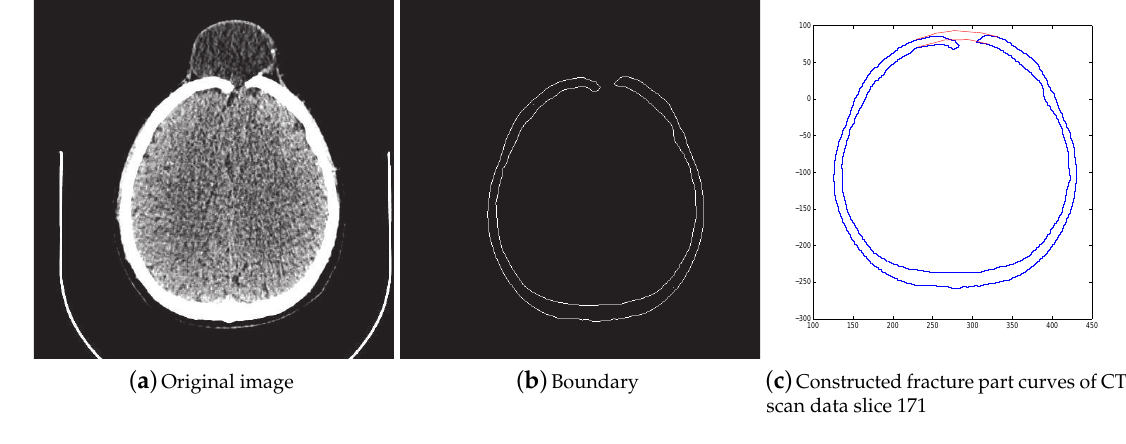
Figure 8. CT scan data slice 171.